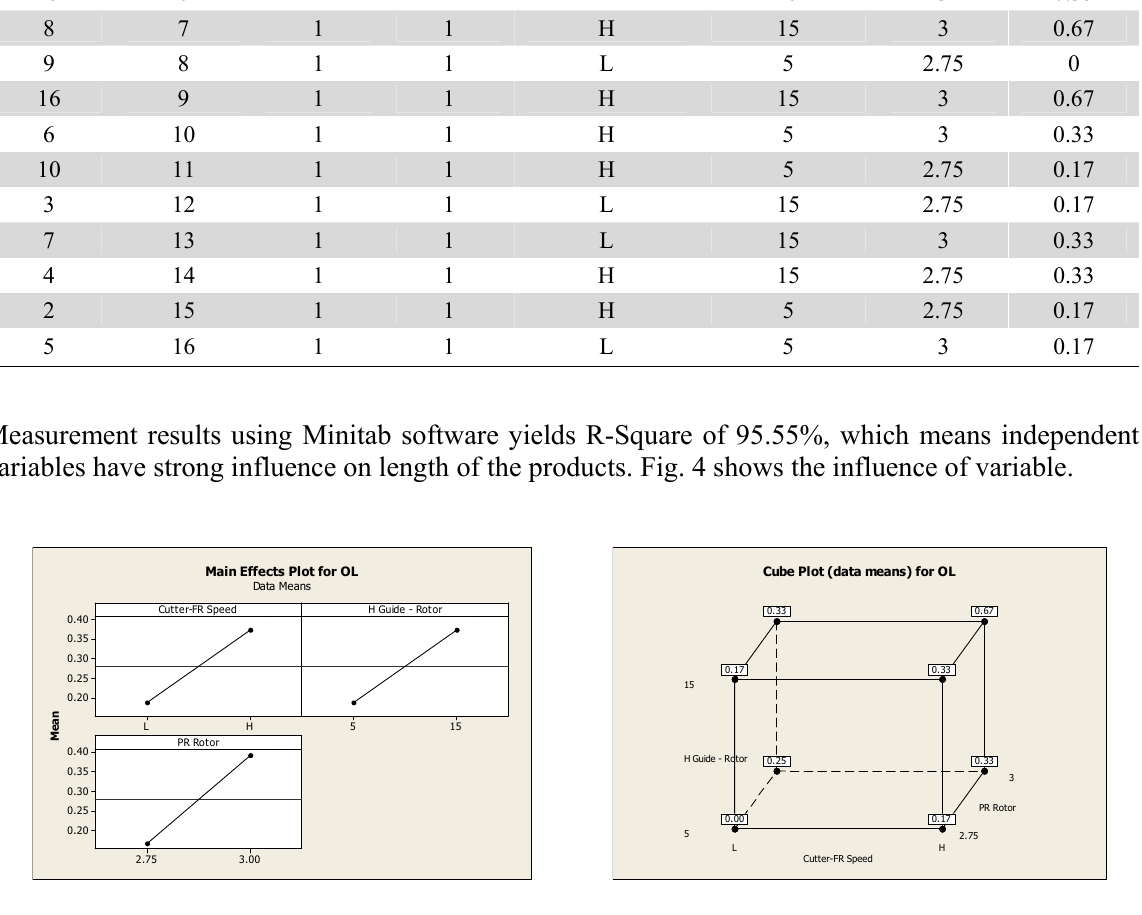
Fig. 4. Design of Experiment in the Cutter